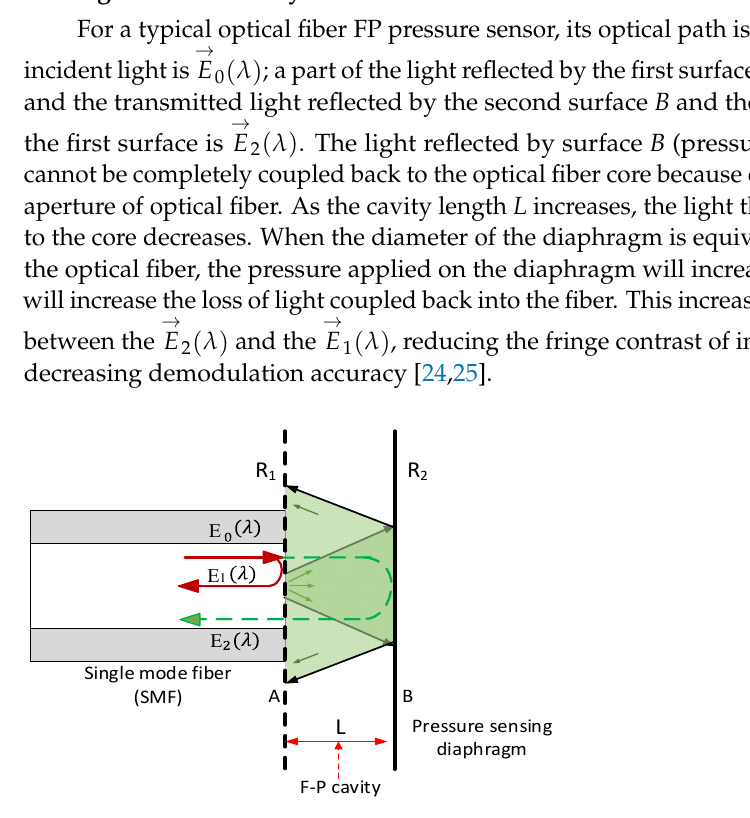
Figure 1. The optical path diagram of the optical fiber FP pressure sensor.